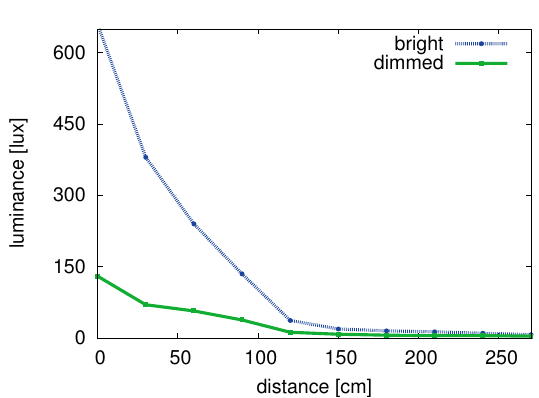
Figure 3: Distribution of light along a centered line from bright light to other side.